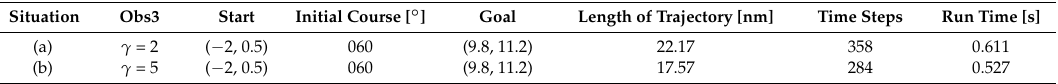
Figure 12. By adjusting the parameter γ of Obs3, the channel between Obs3 and Obs4 is navigable (when γ = 5) or unnavigable (when γ = 2). ( a ) The own ship detects that the potential between Obs3 and Obs4 is higher than the limited potential λ , that is, there are obstacles or non-navigable waters. Therefore, the own ship turns around the right side of Obs4 and finally reaches the goal near Obs5. ( b ) The own ship detects that the potential of the narrow channel between Obs3 and Obs4 is less than the limited potential value λ , which means the water is safe there. Therefore, the own ship passes through this narrow channel and reaches the goal safely. Table 6. Initial inputs for complex static obstacles.